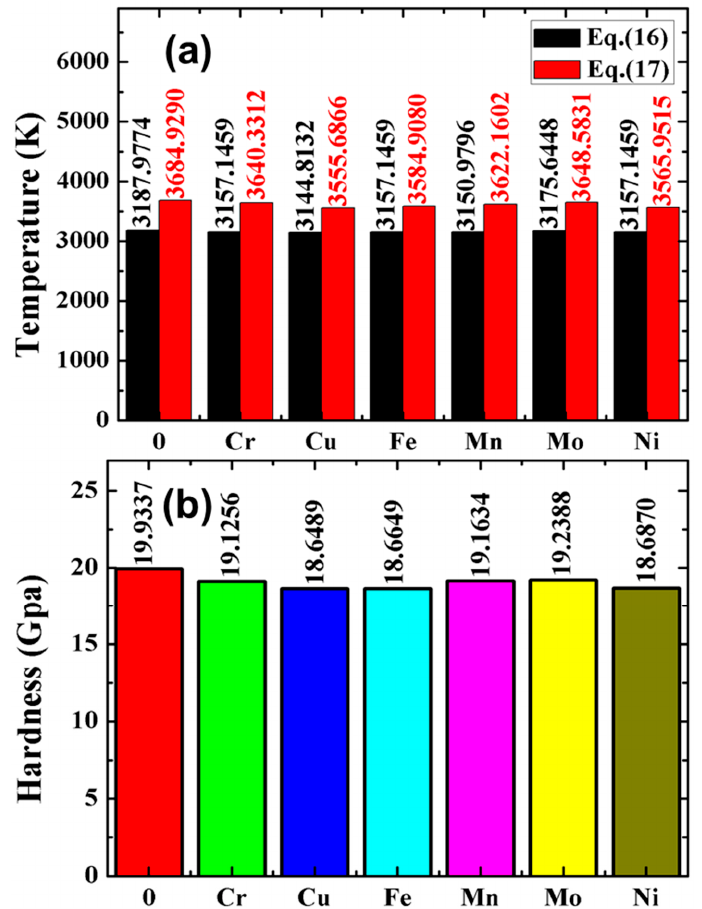
Figure 5. Melting points ( a ) and Hardness ( b ) of pure W and the W-TM (TM = Cr, Cu, Fe, Mn, Mo and Ni, respectively) alloys.